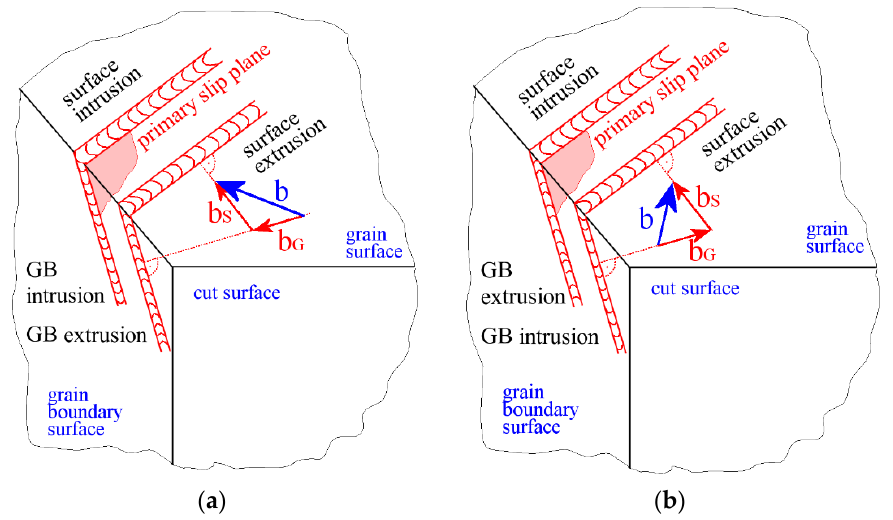
Figure 24. Schematic representation of the two types of PSMs in the grain; ( a ) the component b G of the active Burgers vector in the slip plane is directed towards the grain boundary, ( b ) the component b G of the active Burgers vector in the slip plane is directed away from the grain boundary.